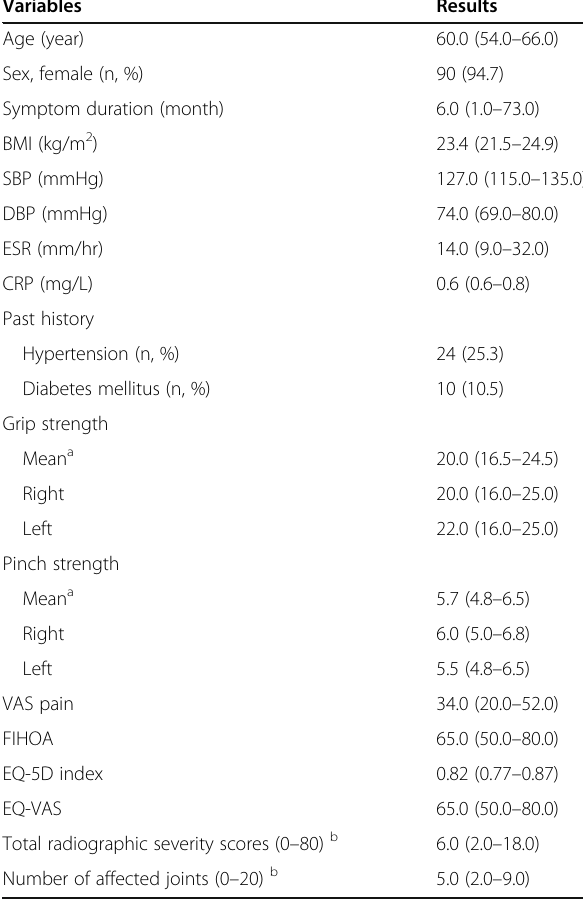
Table 1 Baseline characteristics of enrolled subjects Variables